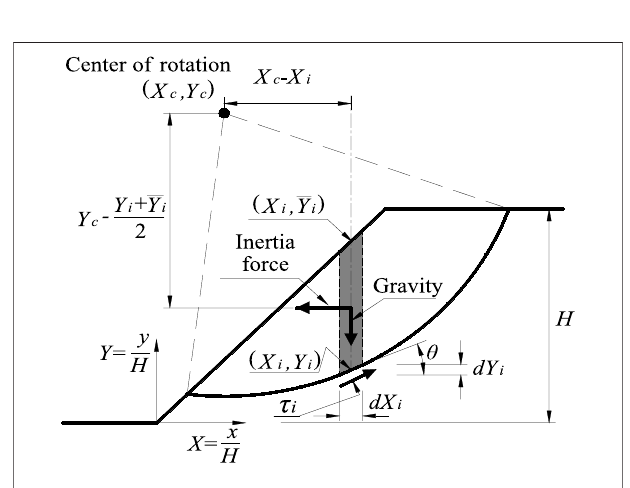
FIGURE 2 | Calculation diagram of the critical slip surface of a homogeneous